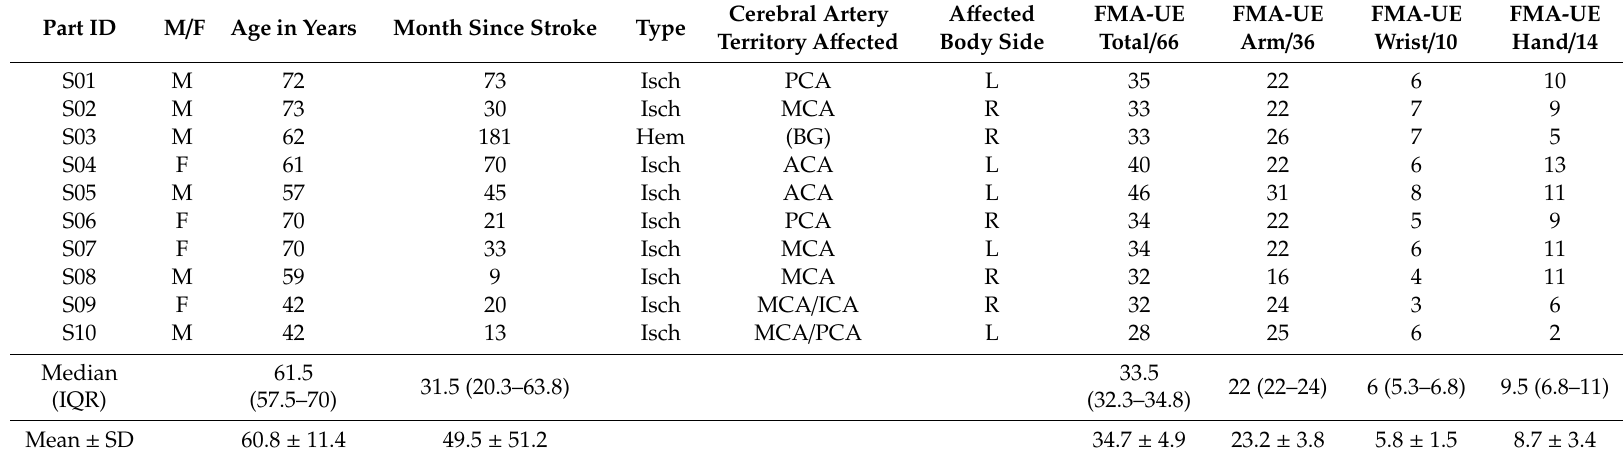
Table 2. Demographic and clinical characteristics of the participants ( n = 10). Subject S02 was discarded from the data